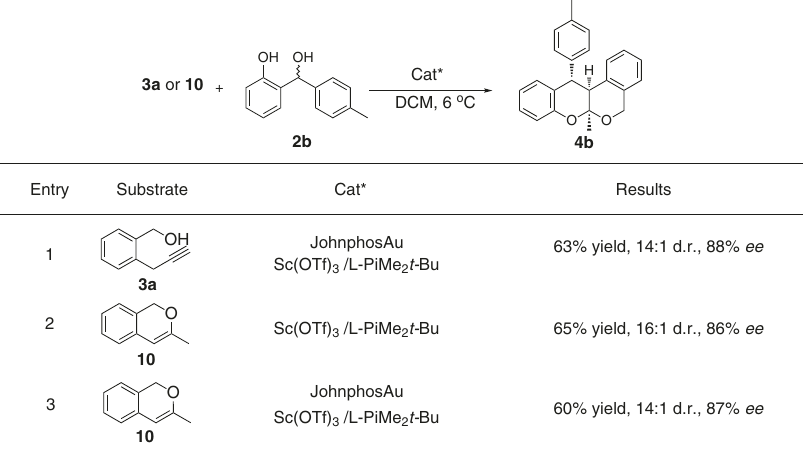
Fig. 7 Controlled experiments. Unless otherwise noted, all reactions were carried out on a 0.2 mmol scale with 1 eq 2b , 1.2 eq 3a or 10 , 10 mol% of Sc (OTf) 3 , 11 mol% of L-PiMe 2 t -Bu and 5 mol% of JohnphosAu in DCM (2.0 mL) under 6 °C.